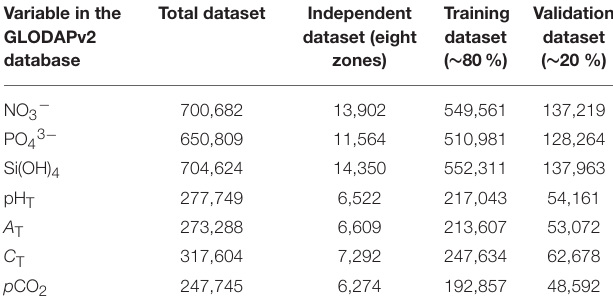
TABLE 1 | Number of data available for each variable in the different datasets used in this study: the general GLODAPv2 database (data that passed the secondary quality control, except for the Mediterranean data), the dataset from the eight independent zones that were first removed from the general database, the dataset used to train the neural network (80 % of the general database minus the eight independent zones), and the dataset used to validate the neural network (20 %).